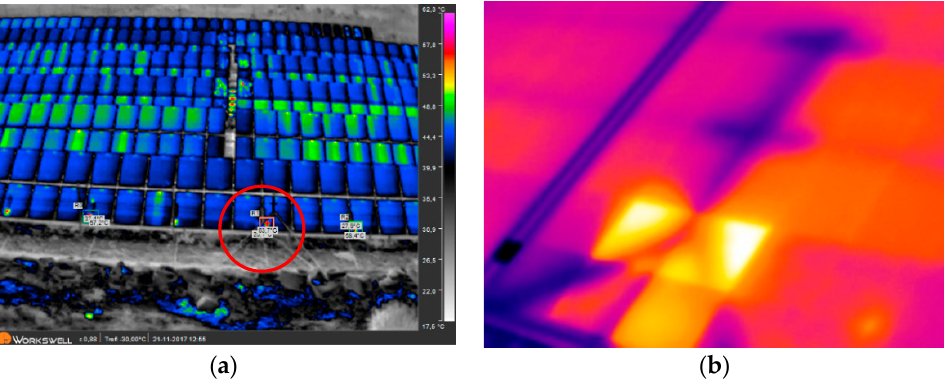
Figure 9. Thermographic analysis with an incident of partial shading: ( a ) aerial IR inspection, and ( b ) ground-level IR inspection. The red circle in ( a ) identifies the affected PV module.